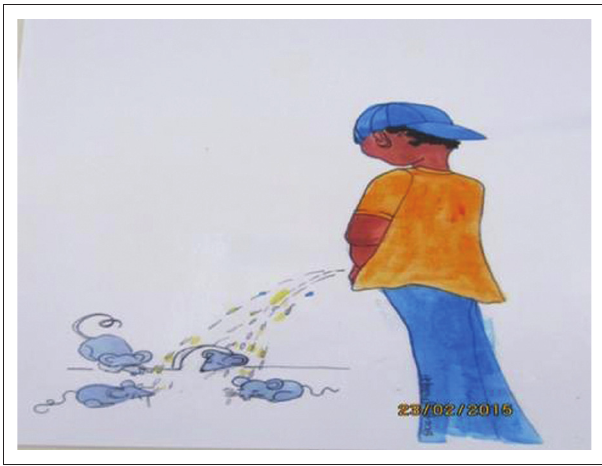
FIGURE 5: A boy urinating.